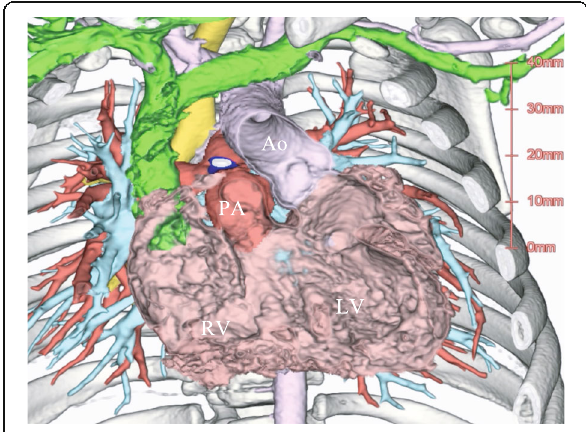
Fig. 1 Preoperative computed tomography image showing the patient ’ s anatomical condition. Abbreviations: Ao, aorta; PA, pulmonary artery; RV, hypoplastic right ventricle; LV, left ventricle